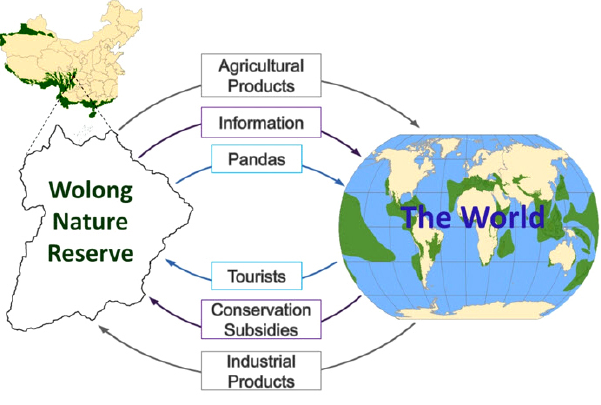
Fig. 1 . Illustration of telecoupling processes between Wolong Nature Reserve in southwest China and the rest of the world. Green areas represent global biodiversity hotspots (Conservation International